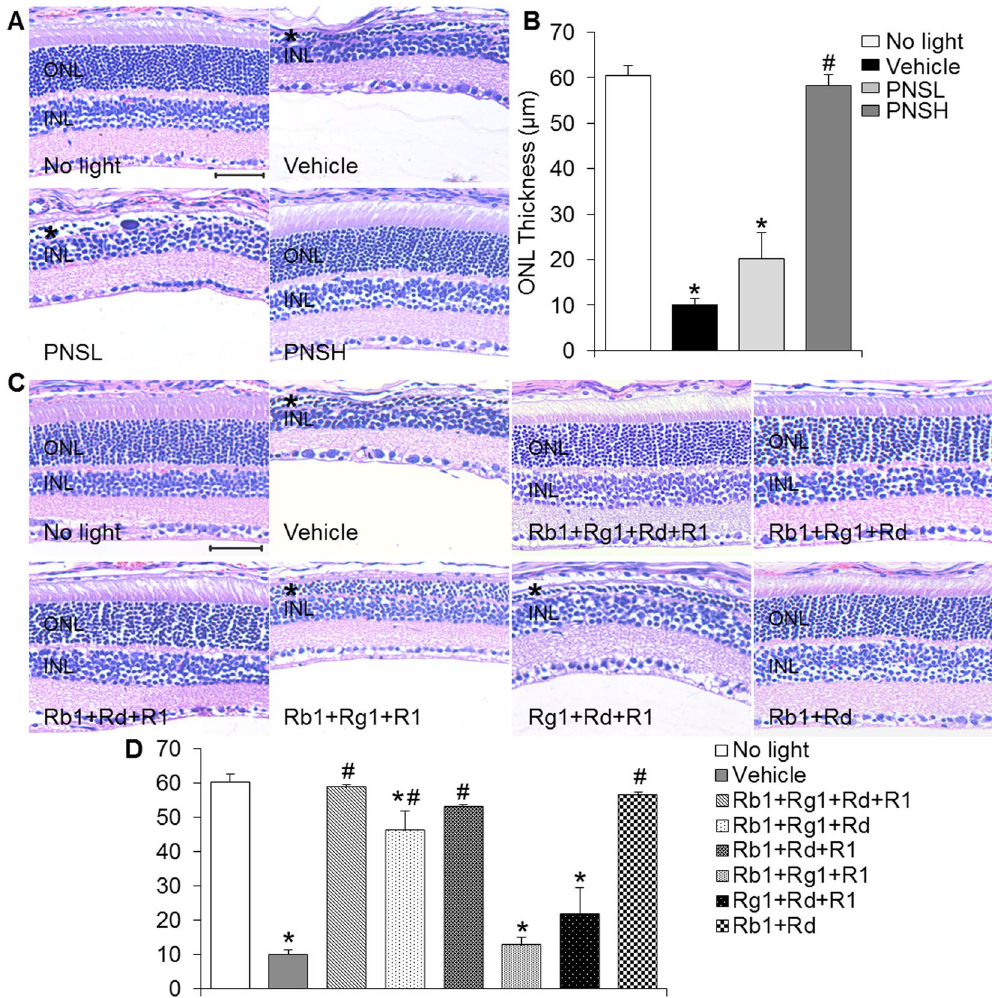
Figure 1. PNS or natural combination of major saponin components of PNS protected retinas from developing bright light-induced degeneration. ( A ) Dar-adapted BALB/c mice were pretreated with saline vehicle (Vehicle), PNS at 50 mg/kg bw (PNSL) and 200 mg/kg bw (PNSH) 30 min before bright light exposure. Saline-treated mice unexposed to bright light (No light) were included as normal controls. Paraffin sections made from enucleated eyes were subject to histological examination by H&E staining (n = 4 per group). ( B ) The ONL thickness was measured at 500 μ m from optic nerve head (ONH) in the superior retina. ( C ) Dark-adapted BALB/c mice were pretreated with the indicated combinations of the major saponins in PNS, which included Rb1 + Rg1 + Rd + R1, Rb1 + Rg1 + Rd, Rb1 + Rd + R1, Rb1 + Rg1 + R1, Rg1 + Rd + R1 and Rb1 + Rd. The dose of each saponin in the combinatorial treatment was determined according to its respective content in PNS and the effective dose of PNS at protecting against bright light-induced photoreceptor degeneration, which was indicated as following: Rb1, 65 mg/kg bw, Rg1, 50 mg/kg bw, Rd, 22.5 mg/kg bw and R1, 18 mg/kg bw. H&E staining was performed to examine retinal morphology (n = 4–8 per group). ( D ) The ONL thickness was measured at 500 μ m from optic nerve head (ONH) in the superior retina. Asterisk indicated ONL manifesting bright light-induced degeneration. INL, inner nuclear layer; ONH, optic nerve head; ONL, outer nuclear layer. Scale bar: 50 μ m. The data were expressed as the mean ± S.E.M (n = 3–8 per group). * Compared to that from No light, p < 0.05; # compared to that from Vehicle, p <